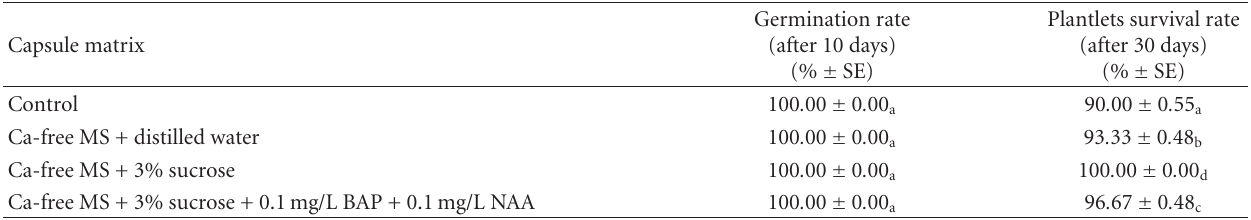
Table 1: Growth response of encapsulated microshoots of Oryza sativa L. Cv. MRQ 74 in di ff erent capsule matrix after being transplanted onto MS media for 10 and 30 days.